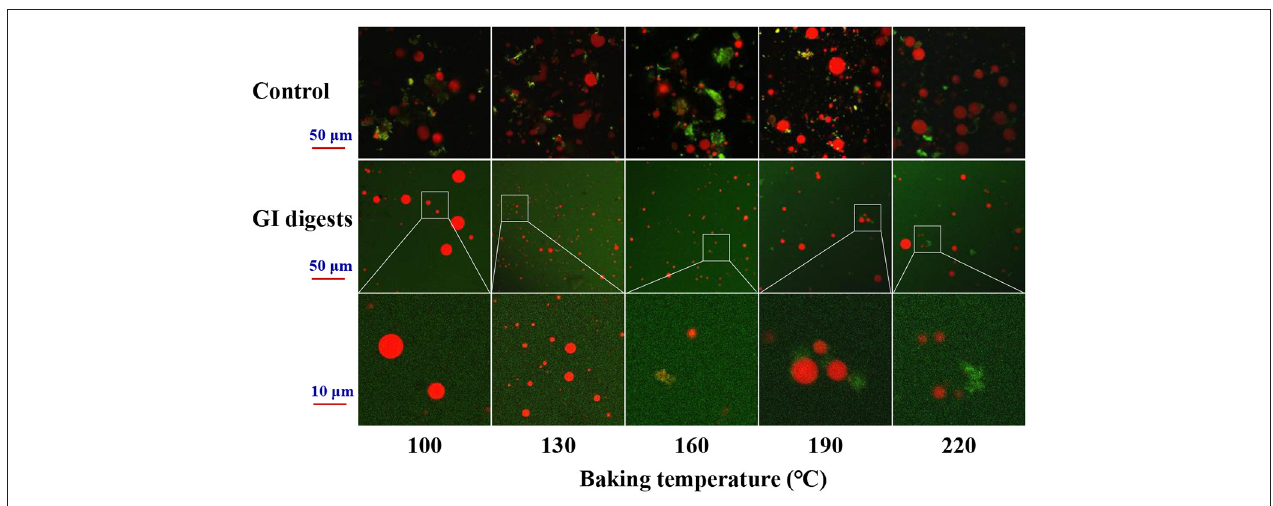
FIGURE 8 | CLSM images of GI digests from baked eel burgers in vitro digestion.